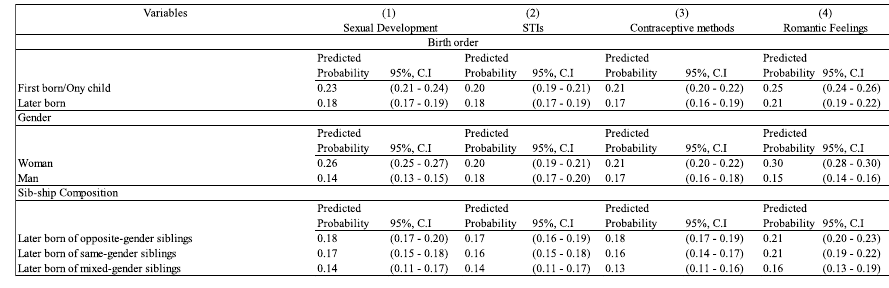
Source: SELFY (2000 and 2017) Note: N = 12,160 for hypothesis 1 and 3. N = 6,213 for hypothesis 3; Predicted probabilities with 95%